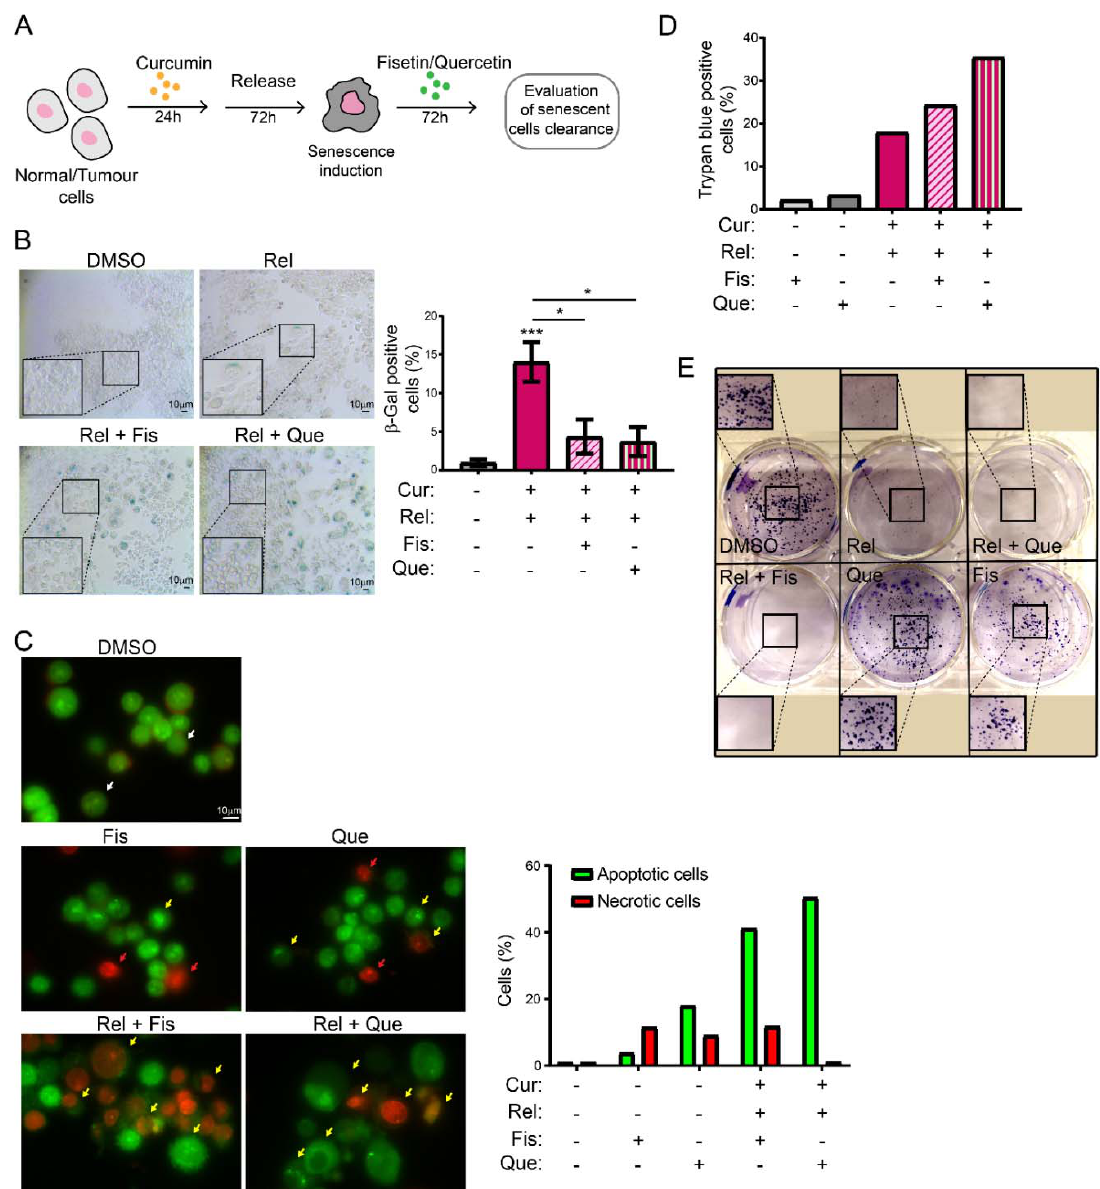
Figure 4. Curcumin-induced senescent cancer cells are cleared by treatment with senolytic drugs ( A ) Schematics of the experiment workflow; ( B ) representative images of SA- β -GAL staining in HCT116 cells after curcumin release and subsequent treatment for 72 h with Fisetin or Quercetin. On the lower-left corner of each image, there is an enlargement of a part of the same image. Graph summarizing the results of two independent experiments with two technical replicates each. Un- paired t-test: *** p < 0.001, * p < 0.05; ( C ) AO/EB double-staining assay for apoptosis detection shows an increase in apoptotic cells following senolytic treatments in curcumin-treated cells. Apoptotic cells (yellow arrow) show membrane blebs and apoptotic vesicles, and fragmented chromatin appears in red following ethidium bromide staining that enters cells when plasma membrane is damaged (necrosis—red arrow). Living cells are uniformly stained in green (white arrow). Scale bar= 10 µm; ( D ) Trypan Blue viability assay showing increased mortality following the double treatments of curcumin + senolytics; ( E ) colony assay demonstrates the impaired proliferation of curcumin-treated cells following senolytics administration.